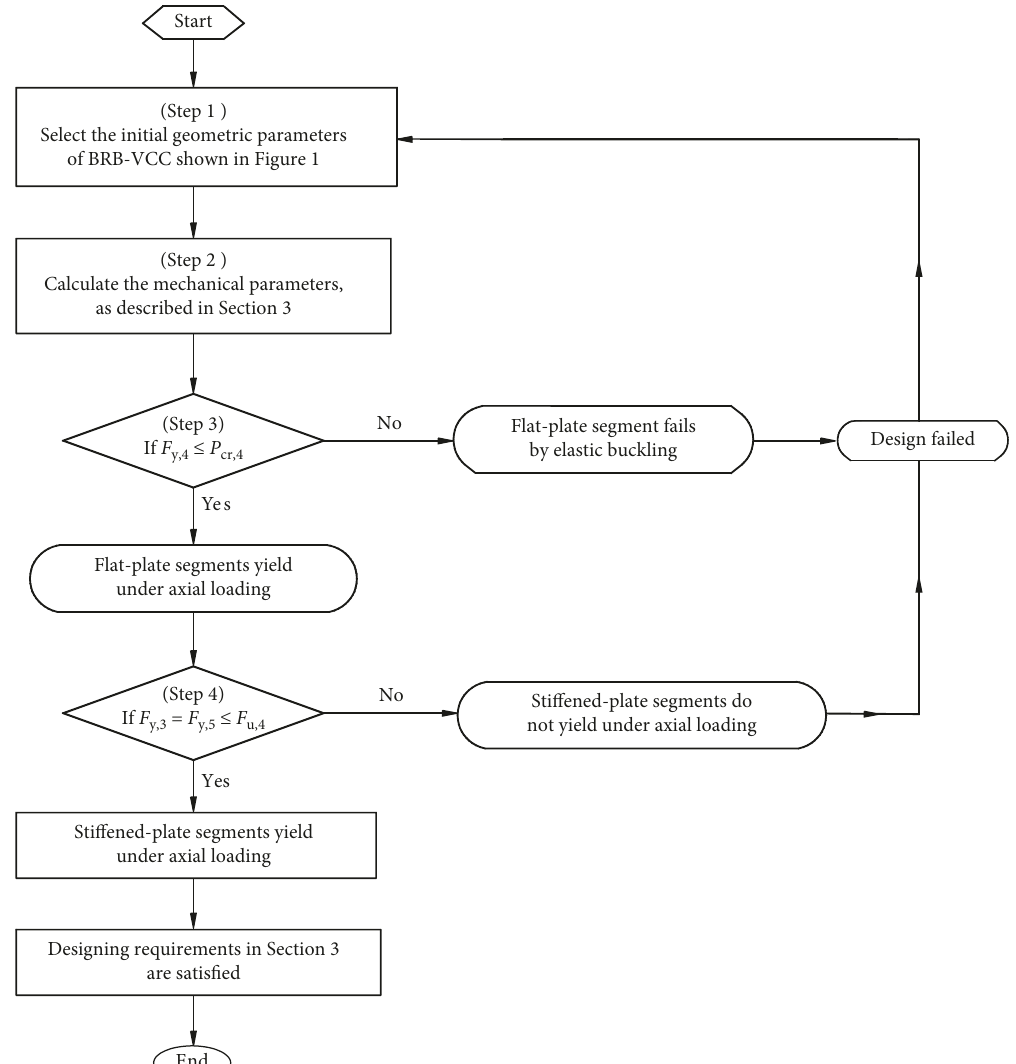
Figure 5: Design process flowchart of